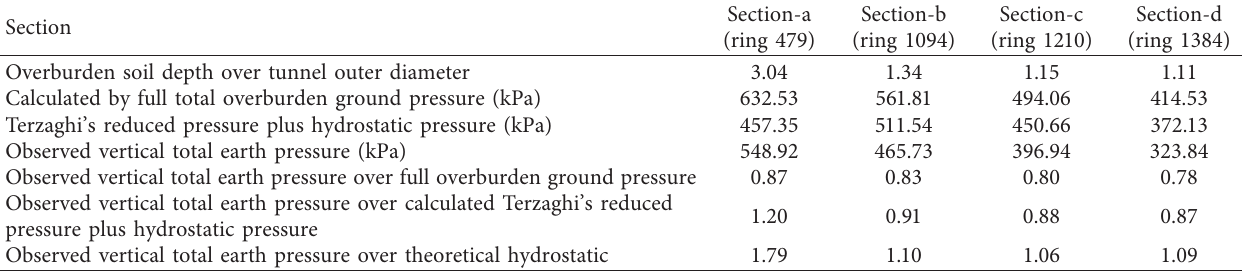
Table 3: Observed total earth pressure acting on the lining on the crown and the theoretical